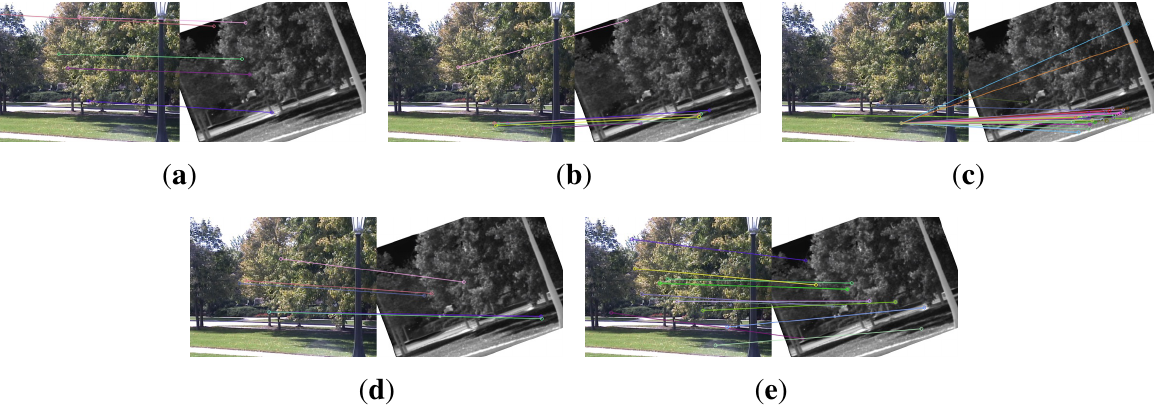
Figure 4. The matched keypoints built with descriptors. ( a ) The original EOH without main orientation; ( b ) the main orientation computed by SIFT, ranging from [0 , 2 π ] ; ( c ) the main orientation computed by center-of-mass (COM); ( d ) the main orientation computed by the histogram of intensities (HOI); ( e ) the proposed method that utilizes the main orientation computed by PIIFD. The test (IR) image is rotated by 20 ◦